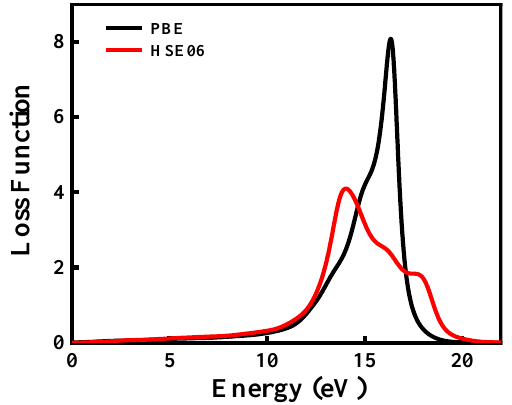
Figure 9. The energy loss function of CdGeAs 2.